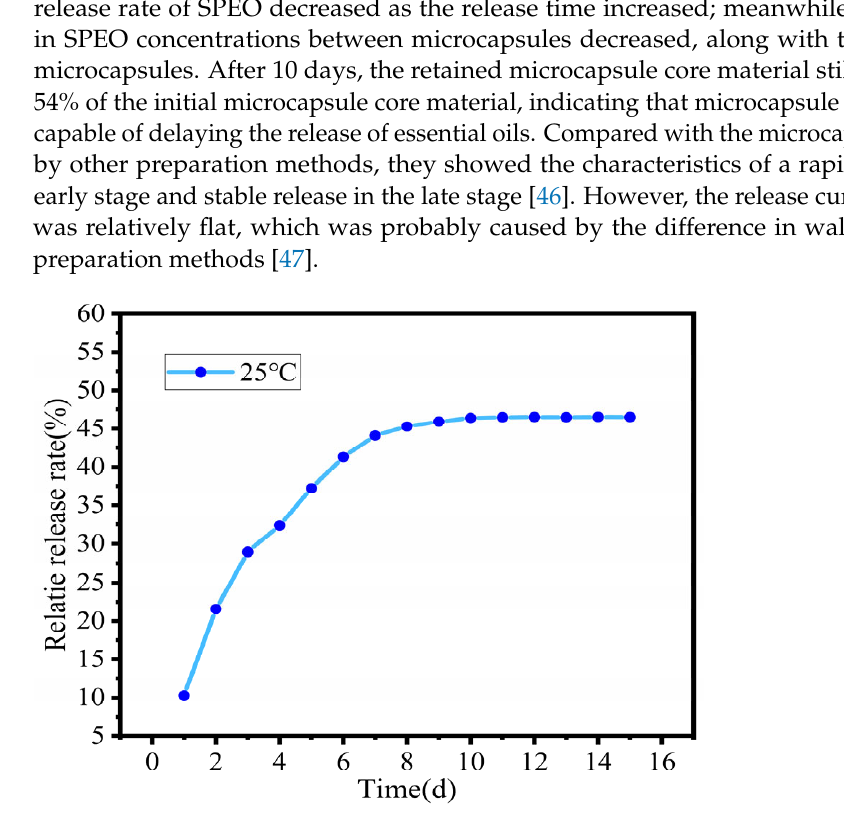
Figure 6. The macroscopic ( a ) and microscopic ( b ) morphology of the microcapsule suspension.